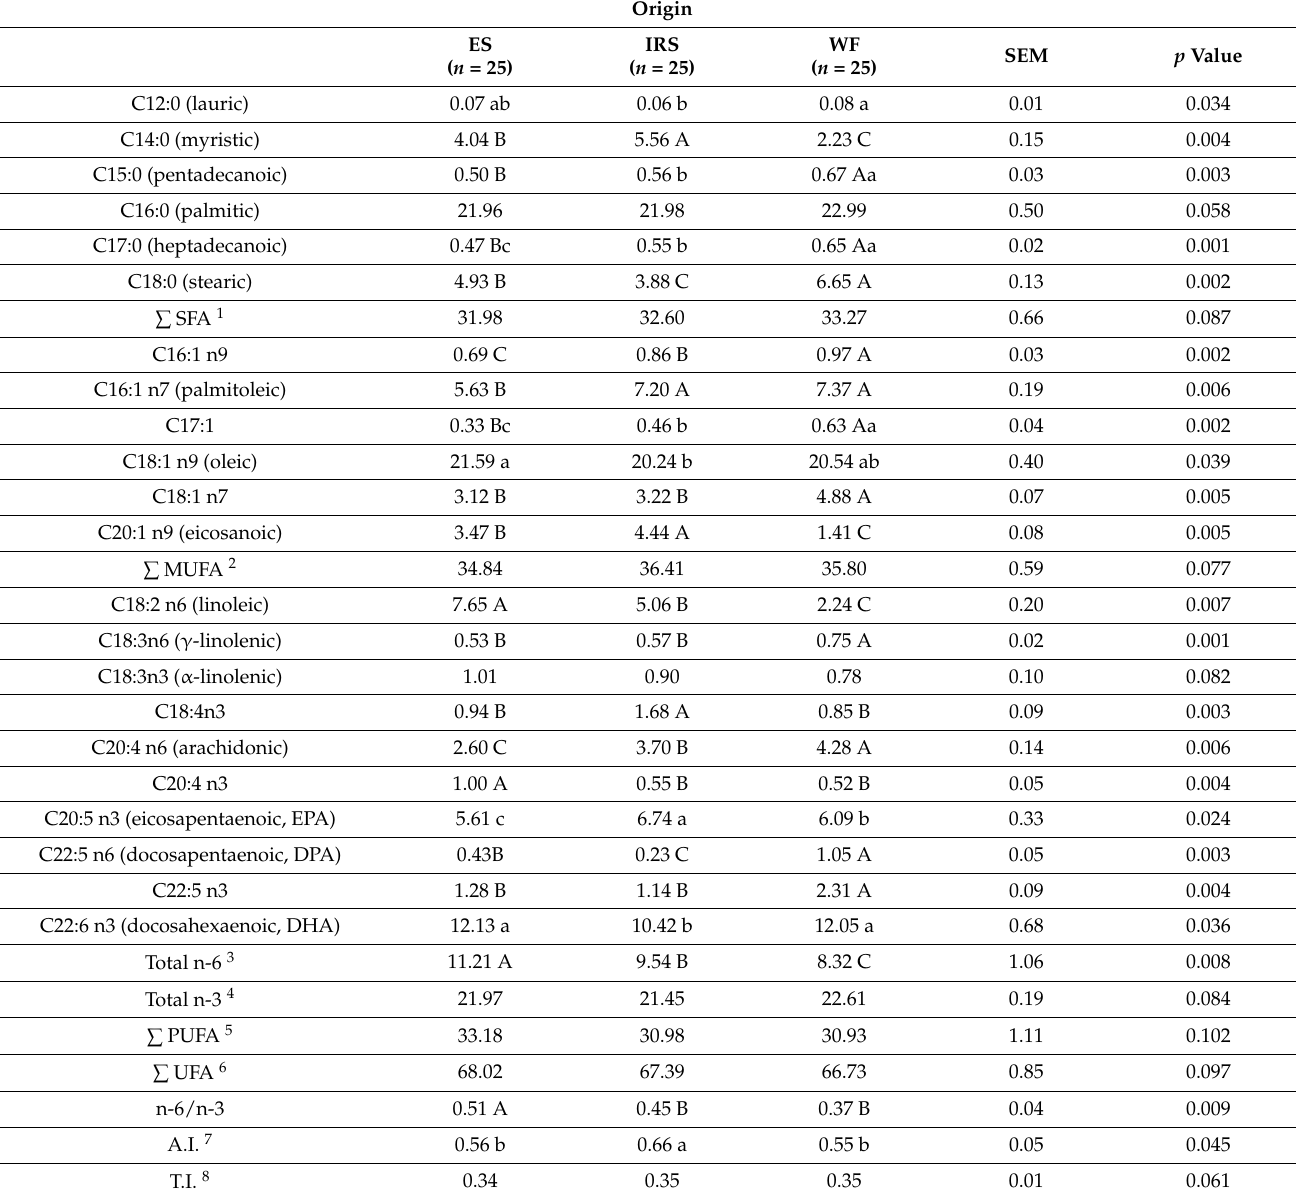
Table 4. Fatty acid profile of fillet of sea bass for each rearing system (% of total FA methyl esters).